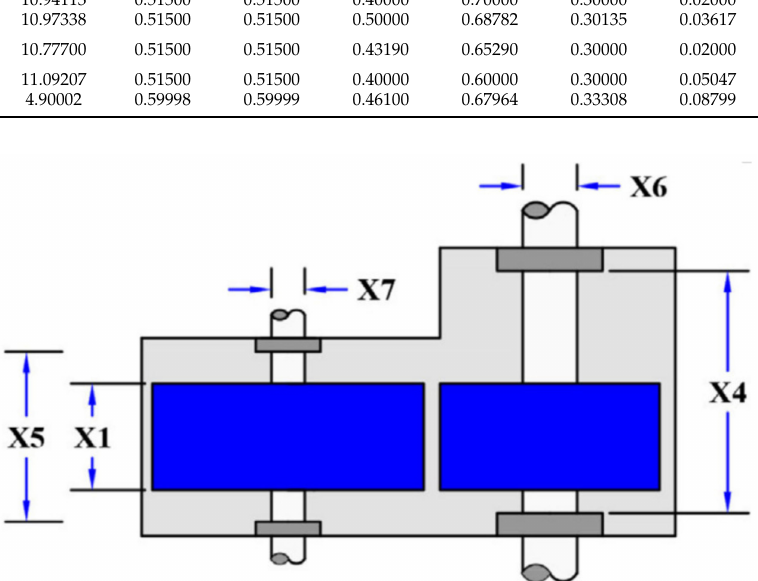
Figure 16. Speed reducer